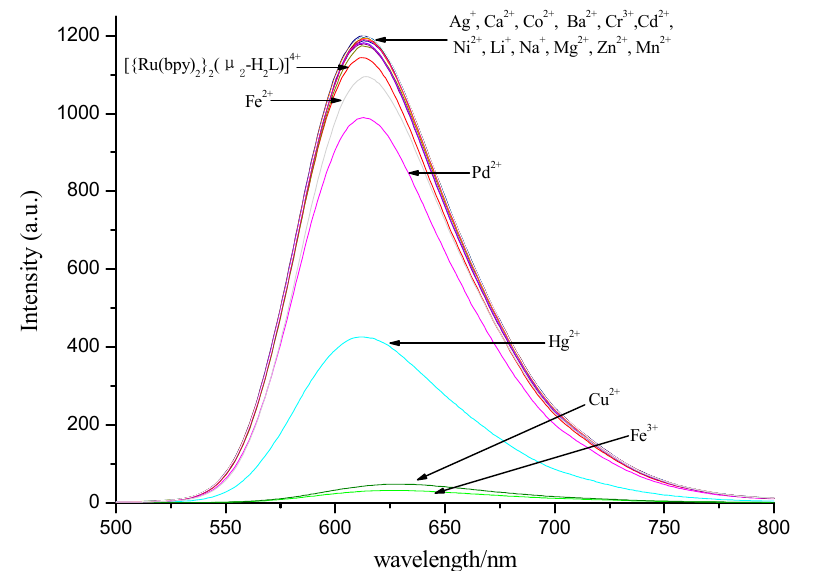
Figure 2. Fluorescence spectra of the complex [{Ru(bpy) 2 } 2 ( μ 2 -H 2 L)] 4+ (10 − 5 mol/L in CH 3 CN/H 2 O = 1:1, v / v , excitation wavelength = 450 nm) upon the addition of 5.0 equivalents of various metal ions at room temperature.